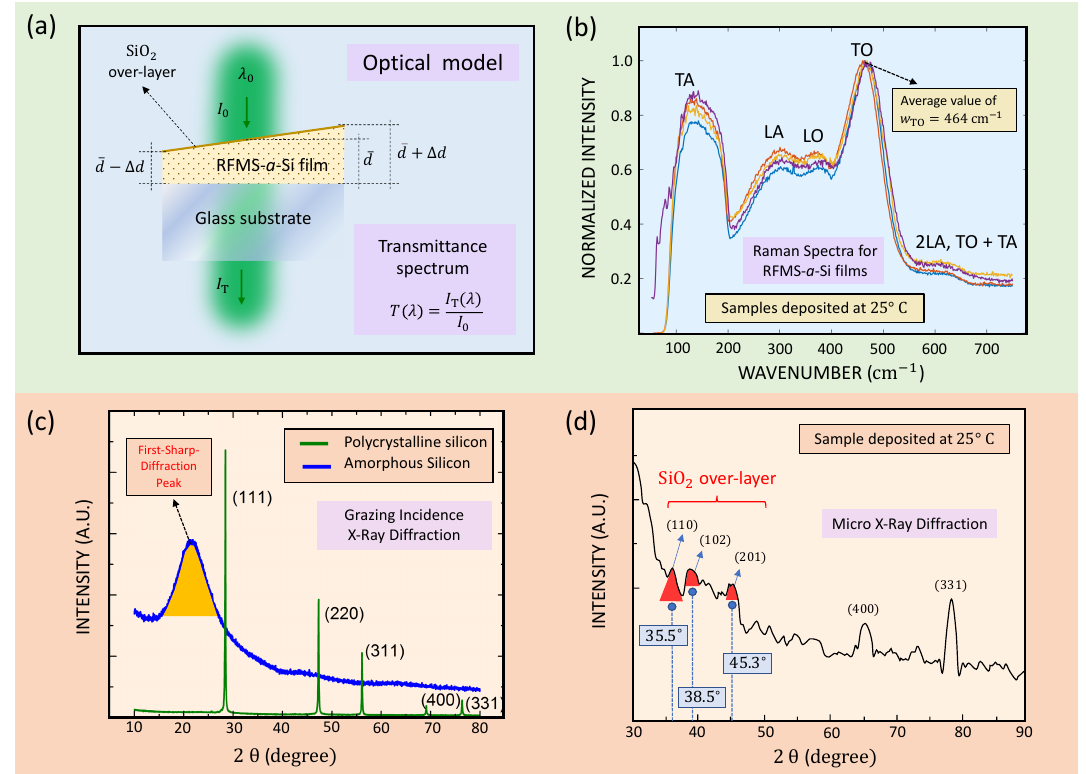
Figure 1. ( a ) A schematic illustration of the wedge-shaped geometry of a thin layer. ( b ) Raman spectra of four a -Si specimens deposited at 25 °C [12,13]. ( c ) Grazing-incidence XRD diagram and ( d ) micro-XRD pattern of an a -Si thin-film sample, grown at a temperature of 25 °C. In the micro-XRD diagram of this particular sample, several pronounced diffraction peaks can be noticed, which can be undoubtedly attributed to SiO 2 peaks (surface native oxide). The two diffraction peaks, ( 400 ) and ( 331 ) , observed exclusively in this particular specimen, can correspond to crystalline planes of silicon indicative of a possible ordered nano-structure (nano-crystalline nature), embedded in the whole and absolutely dominant amorphous matrix (it has been considered negligible from the viewpoint of the assumed optical model)